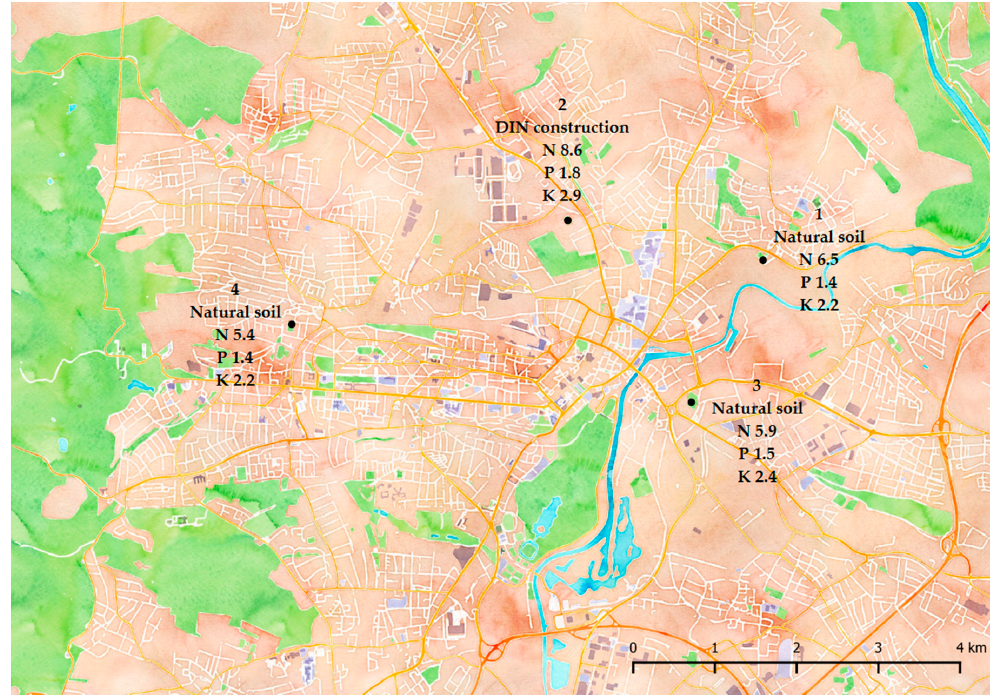
Figure 2. Location of investigated sports fields within the city of Kassel. Soil construction and fertilization in spring 2015 is given. N, P, and K fertilization refers to g·m − 2 ·year − 1 . Underlying map: OpenStreetMap contributors [26].